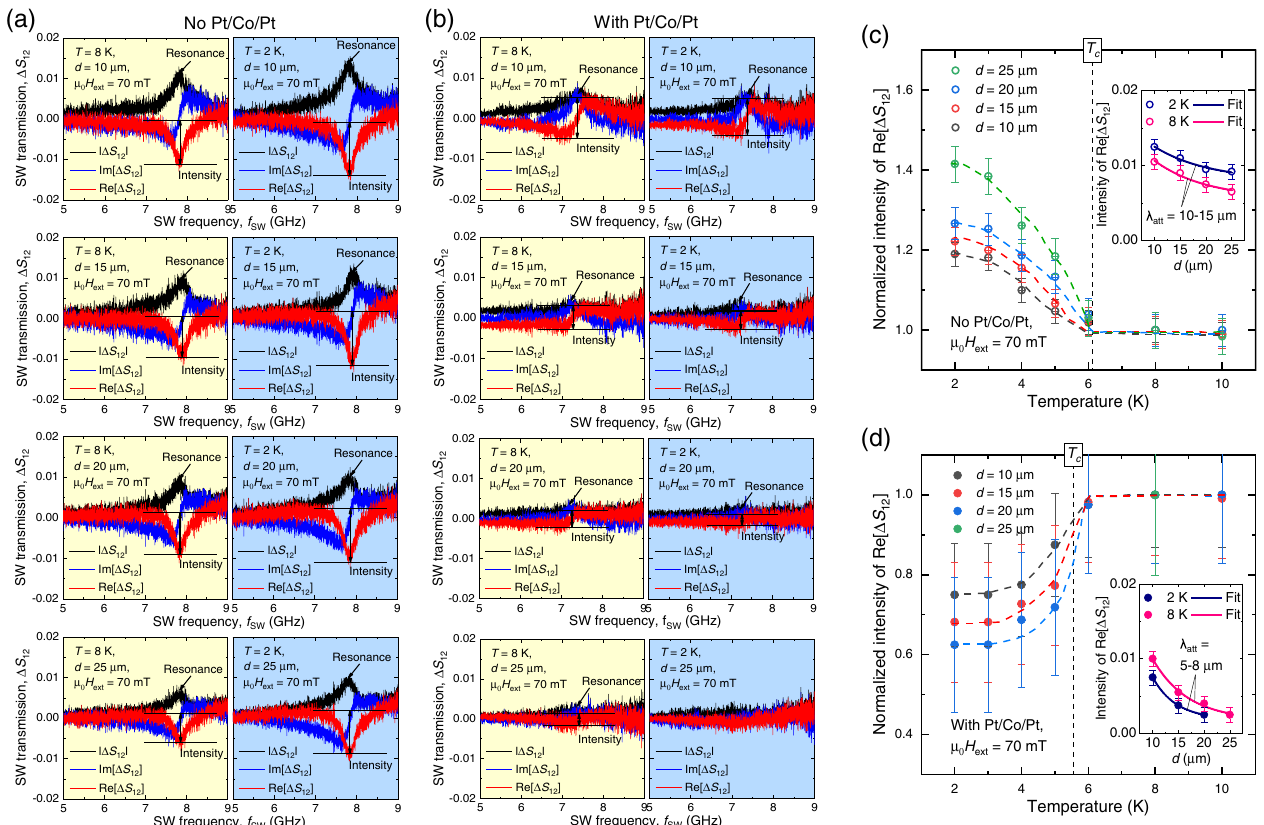
FIG. 4. Experimental realization of superconductor spin-wave (SW) devices. (a) Spin-wave transmission Δ S 12 as a function of frequency f for the Nb ð 30 nm Þ = Ni 8 Fe 2 ð 6 nm Þ = Nb ð 30 nm Þ device with a different distance d ( 10 – 25 μ m) between two separate antennas. These spectra are obtained under application of a fixed external magnetic field μ 0 H ¼ 70 mT above and below T of the c coupled Nb. In each panel, the red, blue, and black curves represent, respectively, the real, imaginary, and absolute of Δ S 12 . (b) Data equivalent to (a) but for the Pt ð 2 . 0 nm Þ = Co ð 0 . 8 nm Þ = Pt ð 1 . 7 nm Þ = Nb ð 30 nm Þ = Ni 8 Fe 2 ð 6 nm Þ = Nb ð 30 nm Þ = Pt ð 1 . 7 nm Þ = Co ð 0 . 8 nm Þ = Pt ð 2 . 0 nm Þ device. (c) Normalized intensity of the real part of Δ S 12 across T for the Pt = Co ð 0 . 8 nm Þ = Pt-absent device with c d ¼ 10 – 25 μ m. (d) Data equivalent to (c) but for the Pt = Co ð 0 . 8 nm Þ = Pt-present device. Each inset shows the associated d dependence of the signal intensity above and below T . The dashed lines in (c) and (d) are guide to the eyes whereas the solid lines in each inset are c fits to an exponential decay function to estimate the SW attenuation length λ [40,41] (see the att